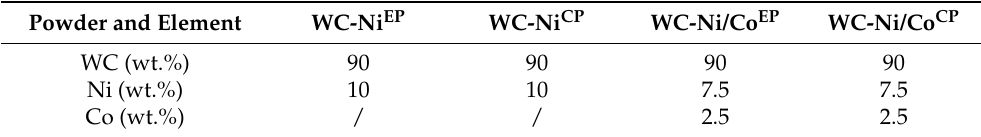
Table 2. Different element mass fraction ratios in composite